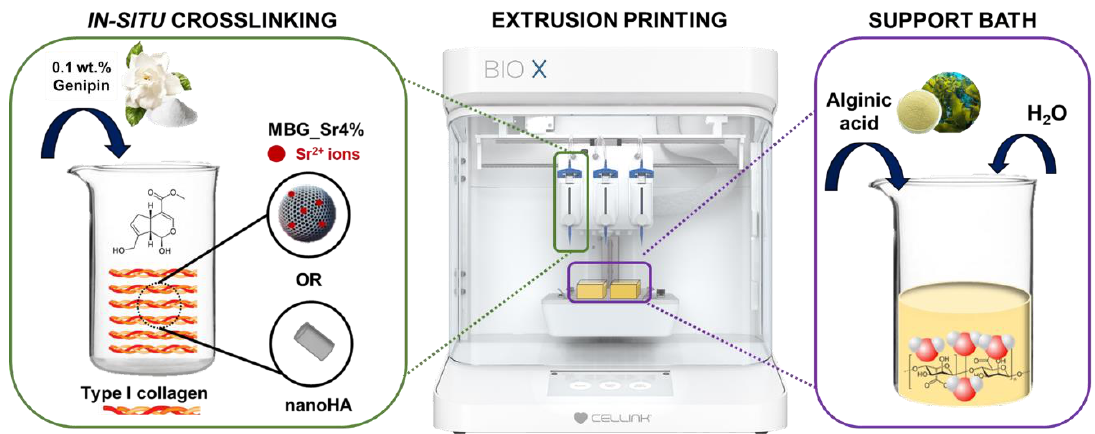
Figure 1. Schematic representation of the developed methodology.